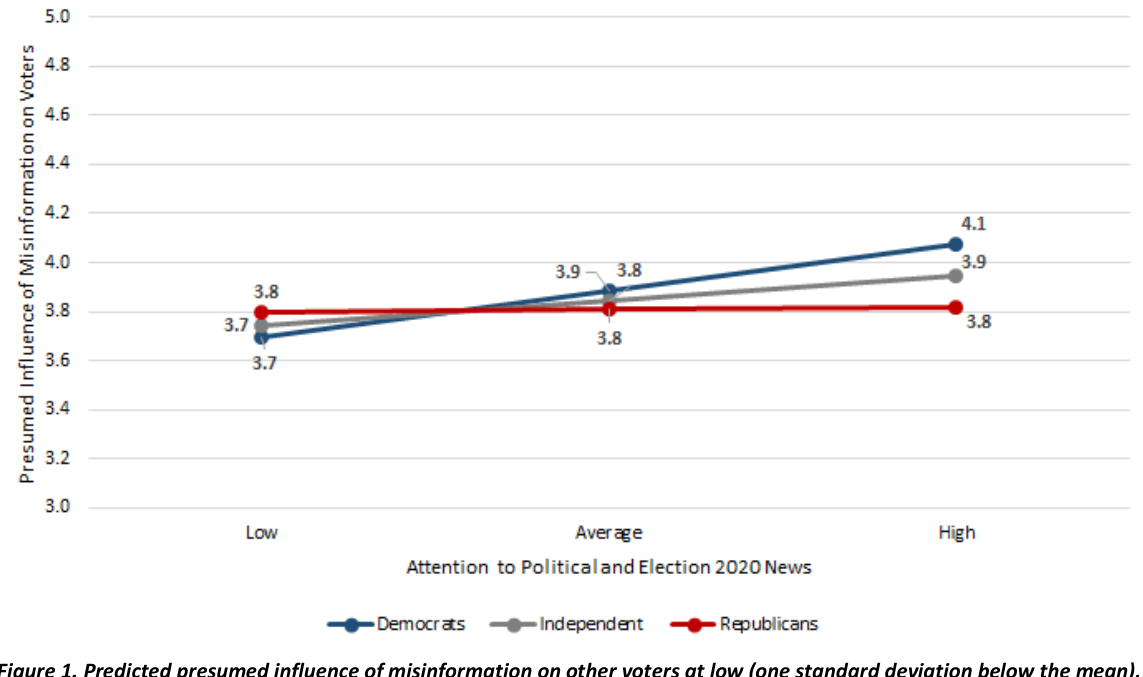
Figure 1. Predicted presumed influence of misinformation on other voters at low (one standard deviation below the mean), mean, and high (one standard deviation above the mean) levels of attention to political and election 2020 news. (See Supplementary Materials for full OLS regression model of